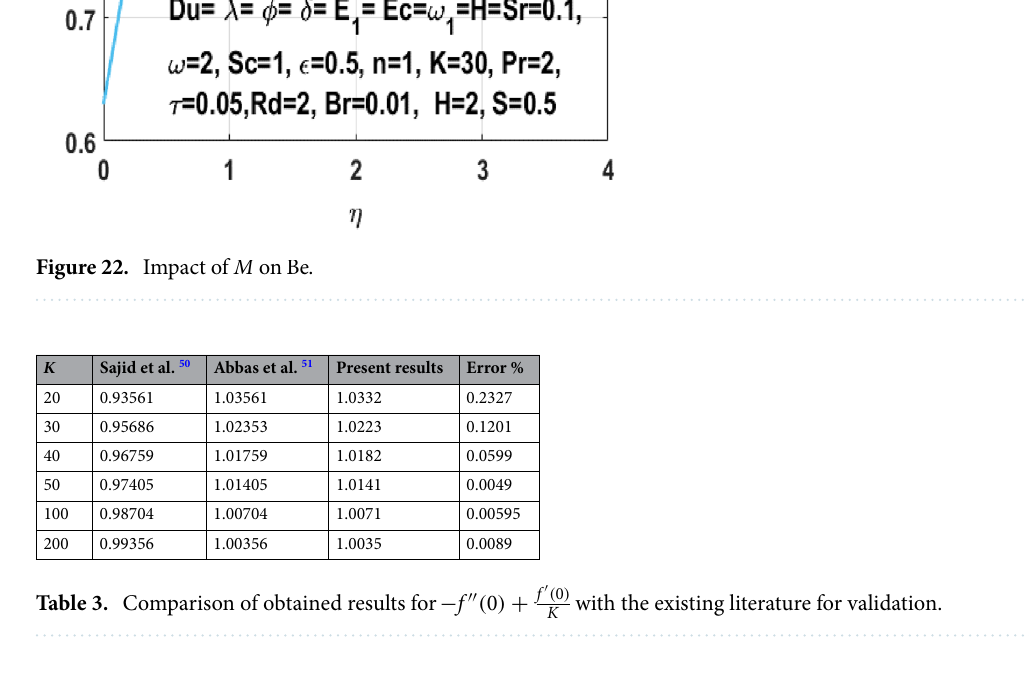
Table 3. Comparison of obtained results for − f ′′ ( 0 ) + f